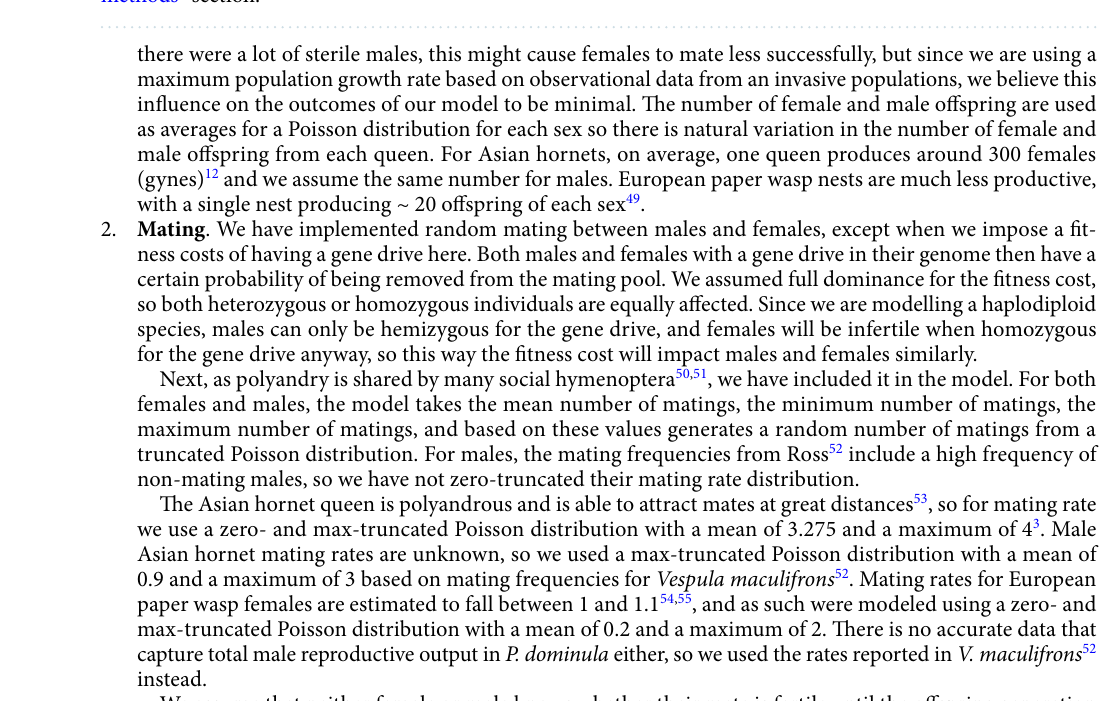
Figure 1. Overview of the demographic model. For a specific explanation of the model, see the “Materials and methods”